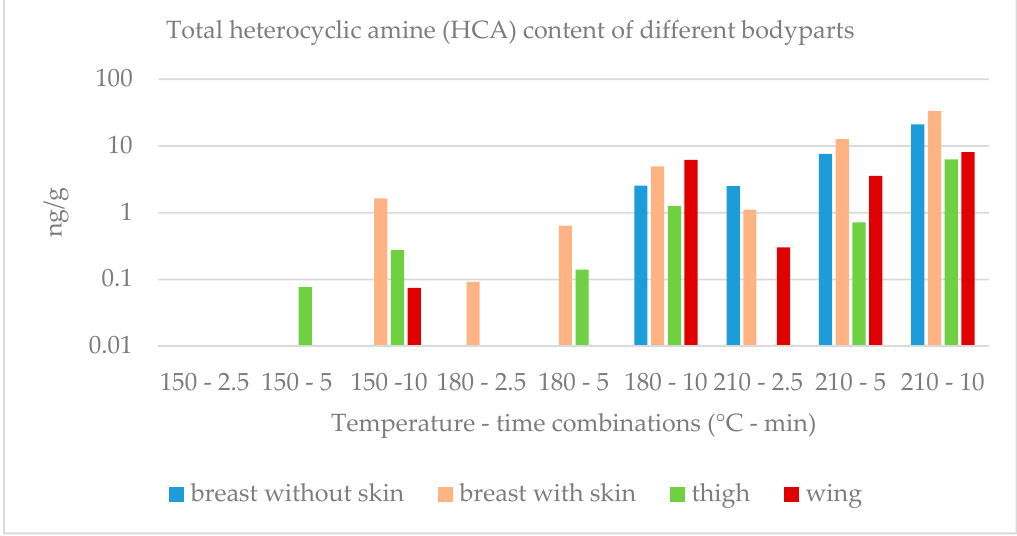
Figure 1. Total heterocyclic amine (HCA) content of chicken breast with and without skin, thigh and wing as a function of grilling temperature and time. (logarithmic scale) A: Breast without skin; B: Breast with skin; C: Thigh; D: Wing; E: Standard calibration.